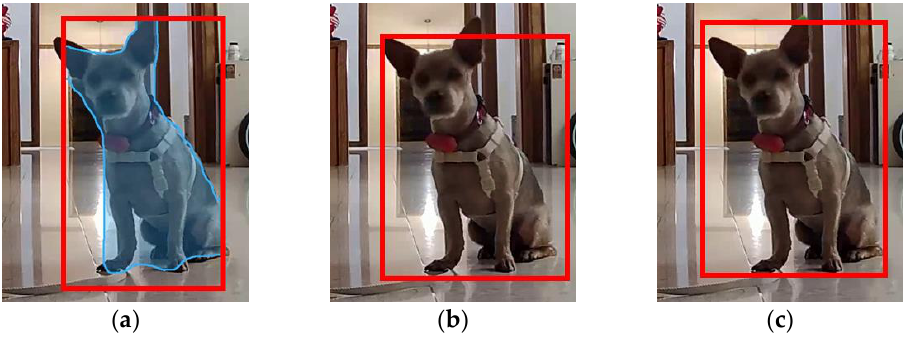
Figure 5. Result of dog detection for “sitting” : ( a ) FasterRCNN; ( b ) YOLOv3; ( c ) YOLOv4.